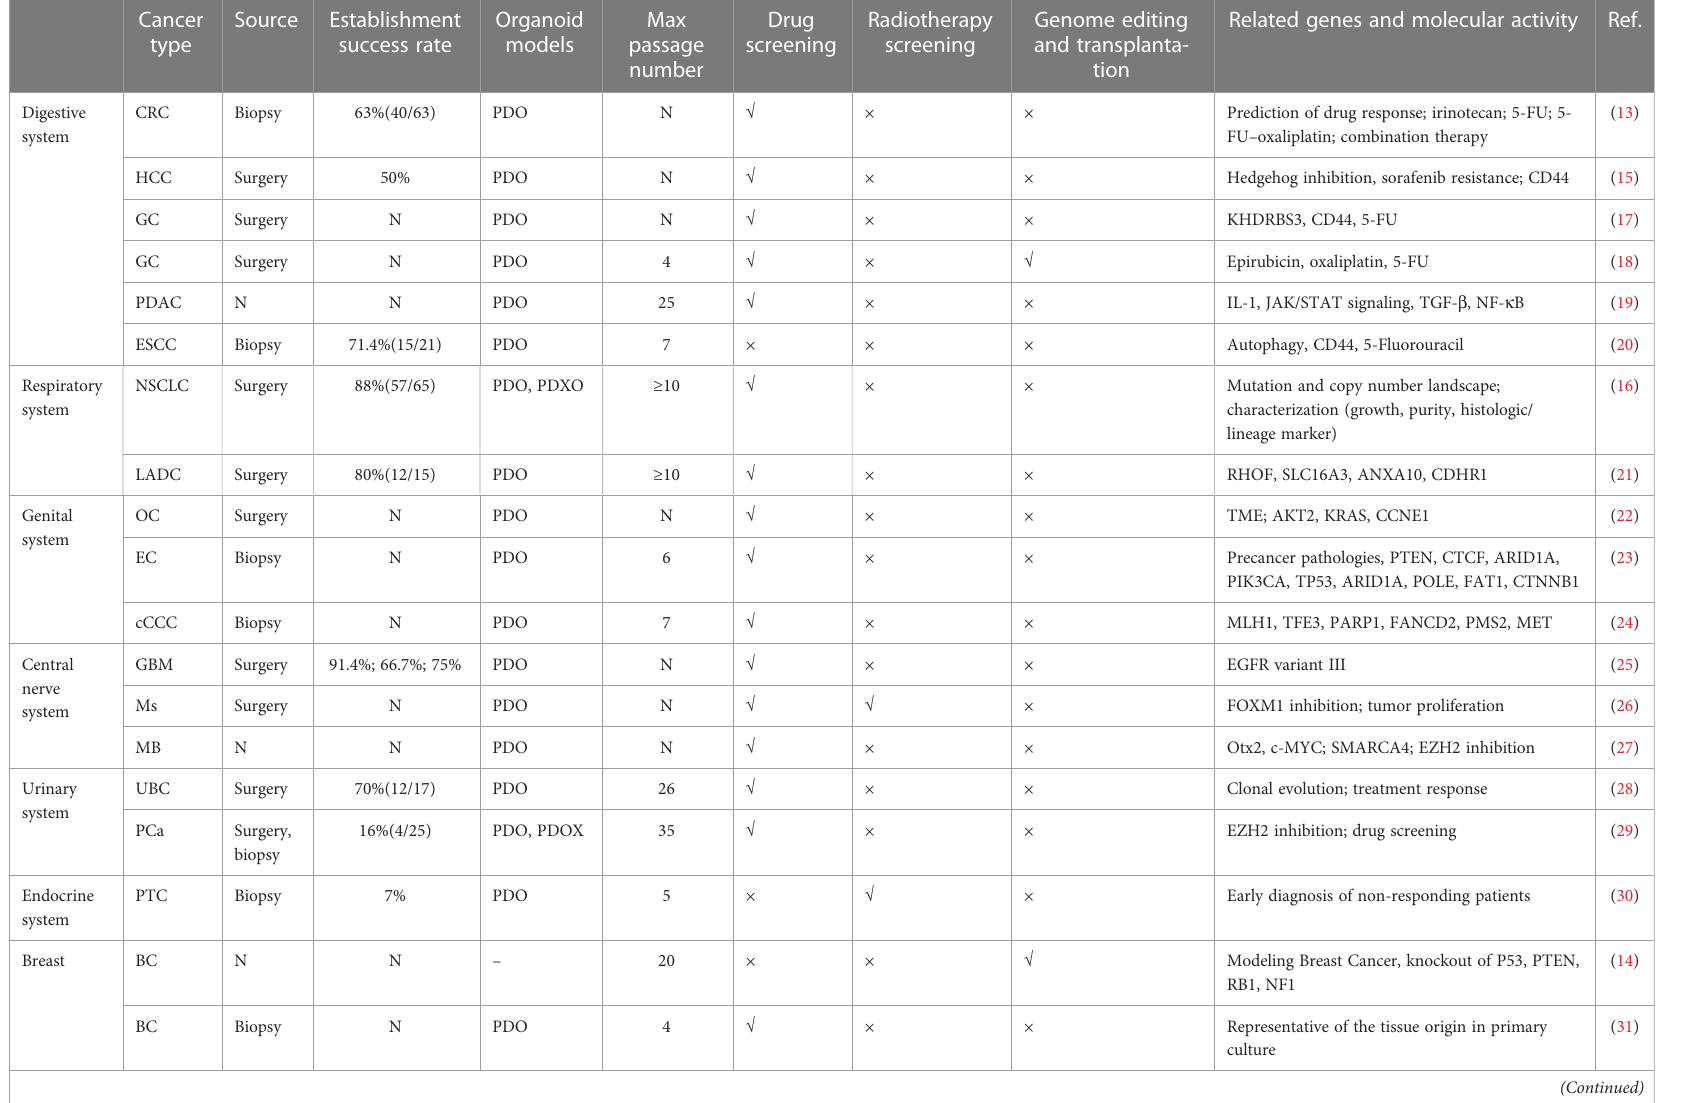
TABLE 1 Applications of organoids in